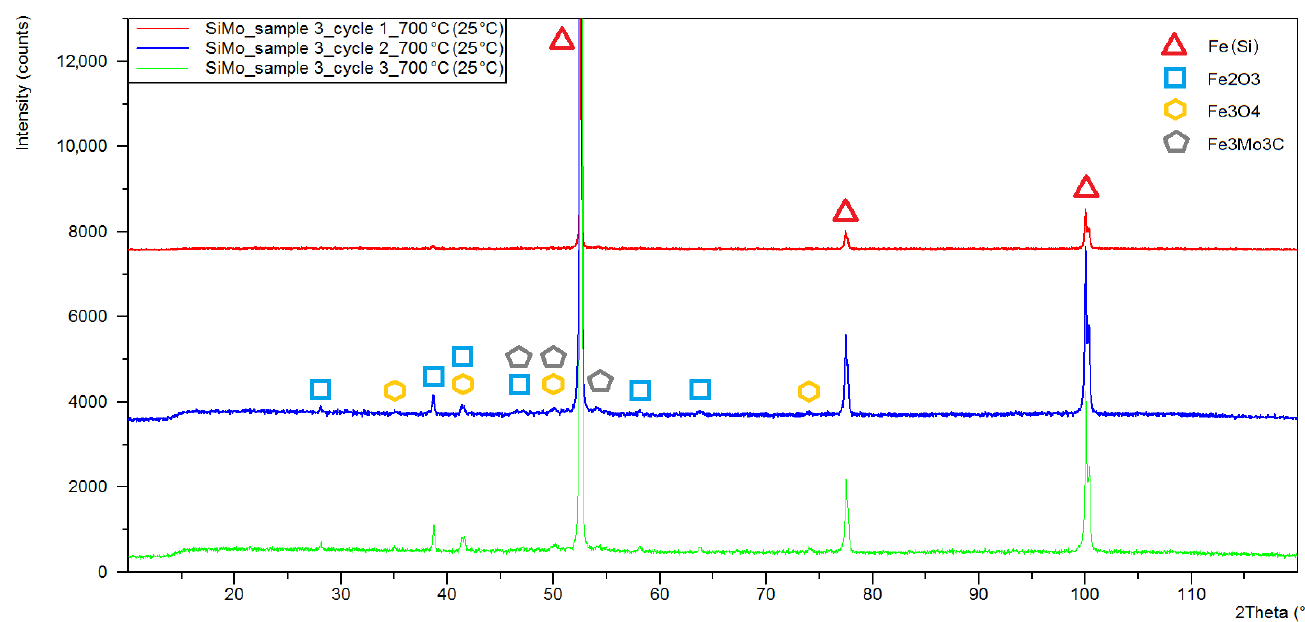
Figure 8. XRD patterns obtained for sample 3 of SiMo cast iron after one (red line), two (blue line) and three (green line) heating cycles at 700 °C. Table 2. Results of quantitative phase analysis.